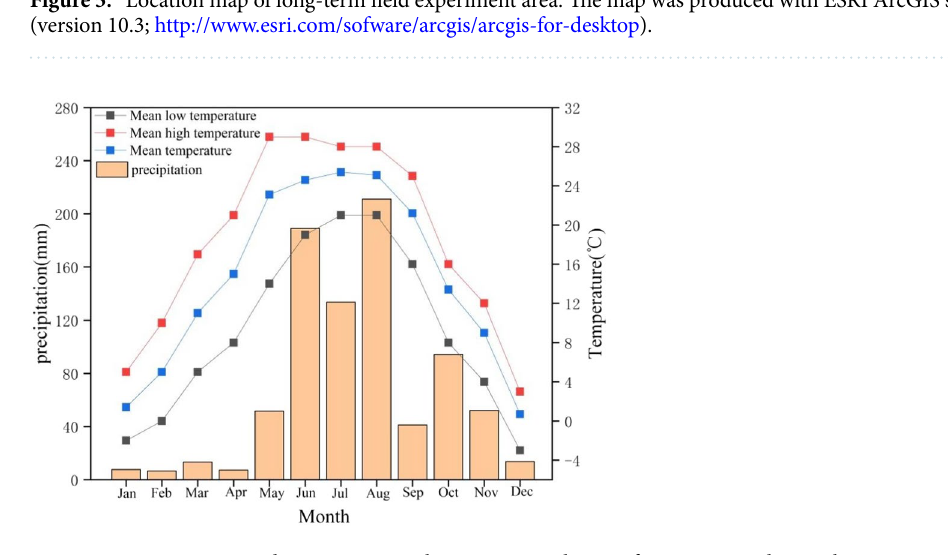
Figure 6. Precipitation and temperature at the experimental site in fuping county during the maize growing season in